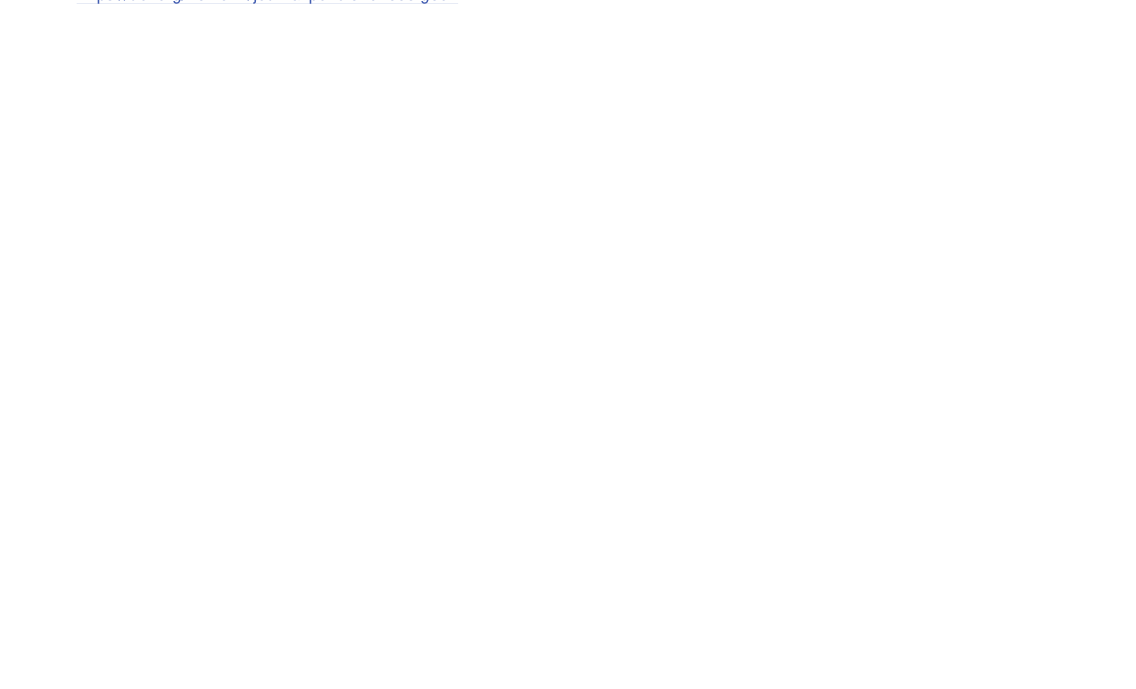
PLOS ONE | https://doi.org/10.1371/journal.pone.0267099 April 28,